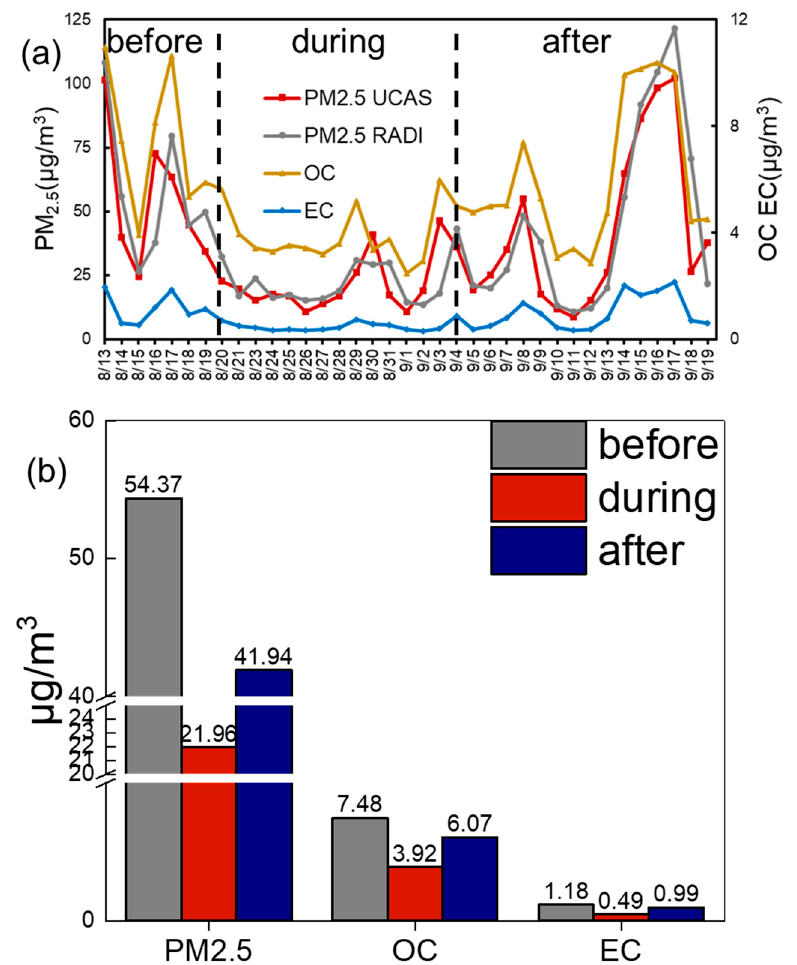
Figure 1. ( a ) shows the concentration of PM 2 . 5 , OC, and EC concentration from off-line samples and online monitoring system from RADI. The dashed lines are the time boundaries of three periods. ( b ) shows the average concentration of PM 2 . 5 , OC, and EC in 3 periods.